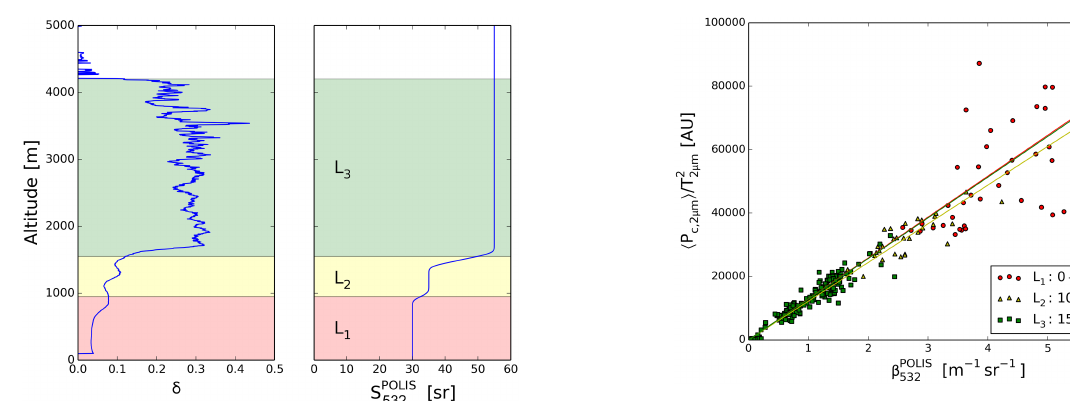
Figure 13. Correlation between the extinction-corrected backscat- Figure 12. Measured particle linear depolarization ratio δ and tered power of the DWL and the POLIS measured backscatter coef- the derived lidar ratio S POLIS for the first calibration overflight ficient for the six calibration overflights on the 26 June and the three 532 (23:56:18–23:56:37UTC) on 26 June obtained by the ground-based different aerosol layers: boundary layer (red dots), mixed layer (yel- lidar POLIS and the aerosol layers with boundary layer L 1 (red, 0 low triangles) and SAL (green to 1000m), mixed layer L 2 (yellow, 1000 to 1500m) and SAL L 3 (green, 1500 to 4200m).